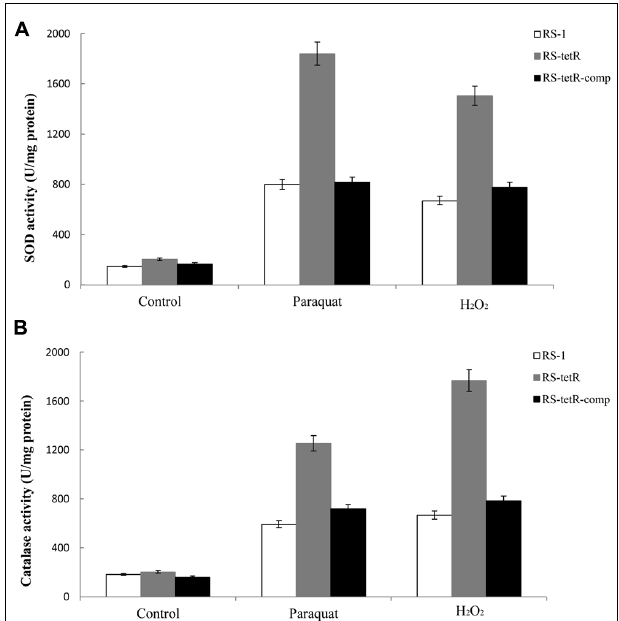
FIGURE 4 |Total SOD (A) and catalase (B) activities in response to superoxide and peroxide stress. Enzyme activities of different strains were evaluated using cytoplasmic proteins after 60 min induction with oxidative compounds (0.4/0.8 mM paraquat or 40/60 mM H 2 O 2 , RS-1 and RS- tetR -comp/RS- tetR ). Error bars indicated standard deviations from three independent experiments.